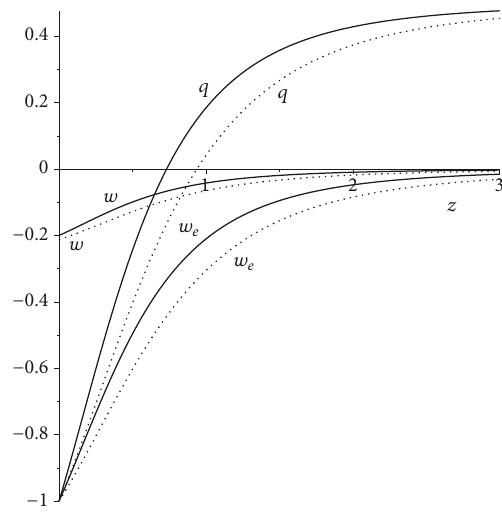
Figure 2: 𝑤 𝑒 , 𝑤 , and 𝑞 versus 𝑧 when 𝑤 0 = −1 . Solid lines: 𝛽 = 5 . Dot lines: 𝛽 = 4.7